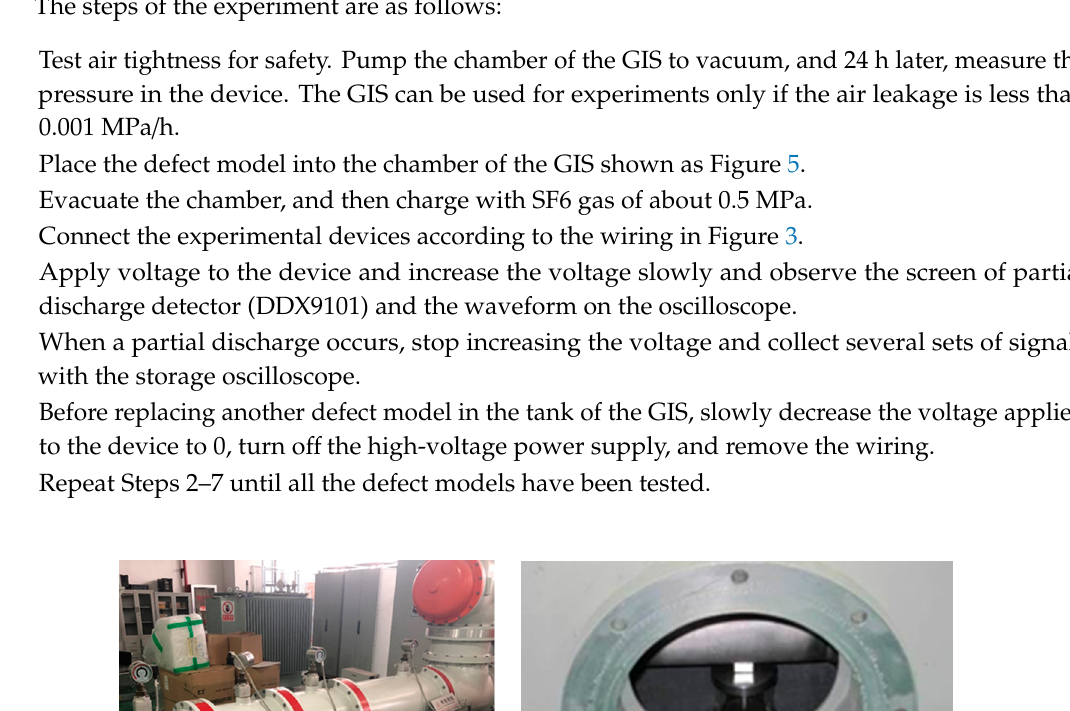
Figure 4. The designs of four typical kinds of insulation defects. ( a ) Metal protrusion; ( b ) Floating electrode; (c) Free metal particles; ( d ) Creeping discharge.